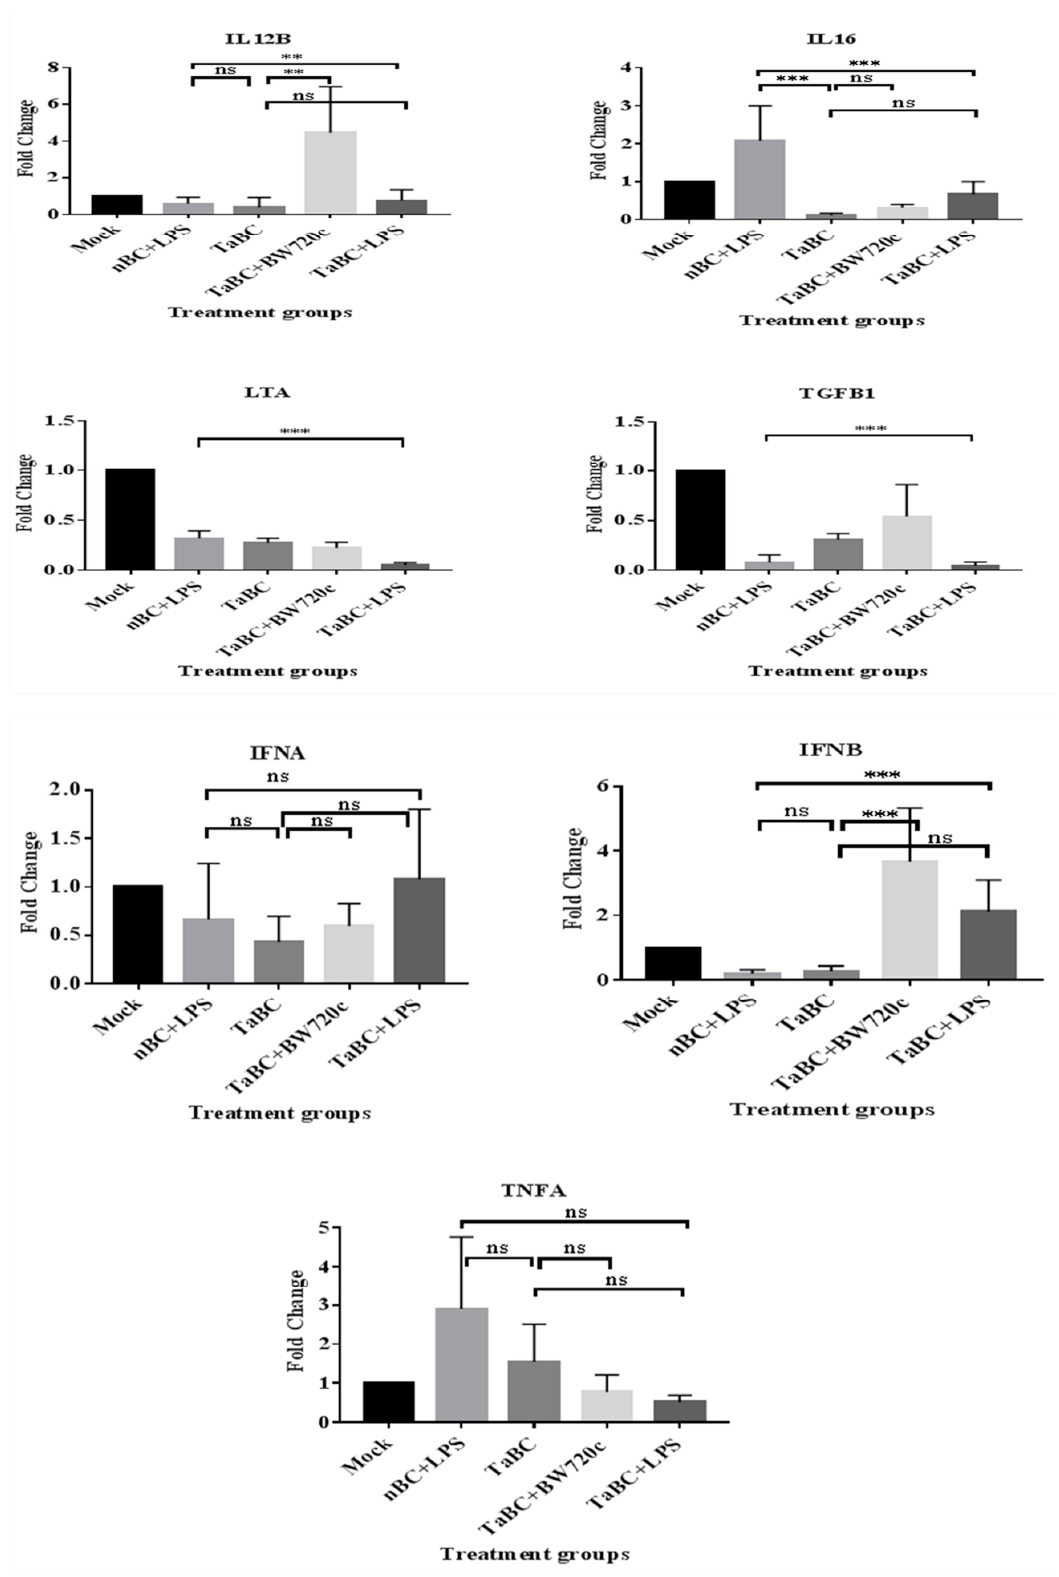
Figure 11. Transcript levels of cytokines in monoclonal T. anuulata -transformed B cells (TaBCs), BW720c-treated transformed cells, and LPS-stimulated TaBCs and normal B cells (nBCs). Here, *** p < 0.001, ** p < 0.01, * p < 0.05, and ns is not significant.